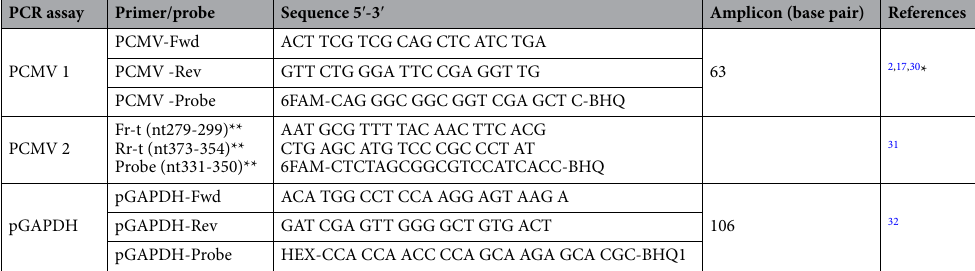
Table 1. Primers and probes used in this study. *The PCMV real-time PCR was modified and performed as duplex PCR. **nt, nucleotide, GenBank AJ222640. PCR polymerase chain reaction, PCMV porcine cytomegalovirus, pGAPDH porcine glyceraldehyde-3-phosphate dehydrogenase, Fwd forward primer, Rev reverse primer, nt nucleotide, 6FAM 6-Carboxyfluorescein, BHQ black hole quencher, HEX Hexachloro- fluorescein.